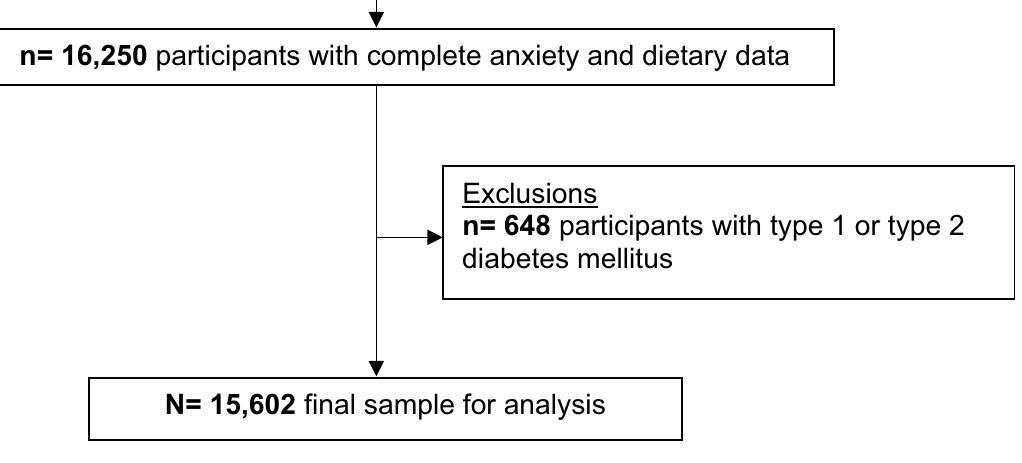
Figure 1. Participant selection